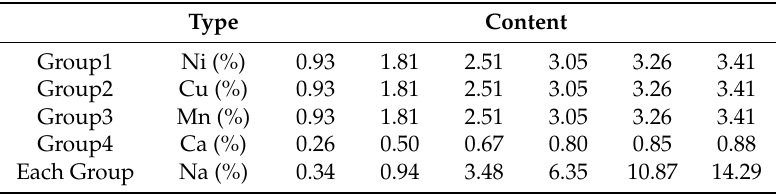
Table 2. Type and mass fraction of the metal contaminants.